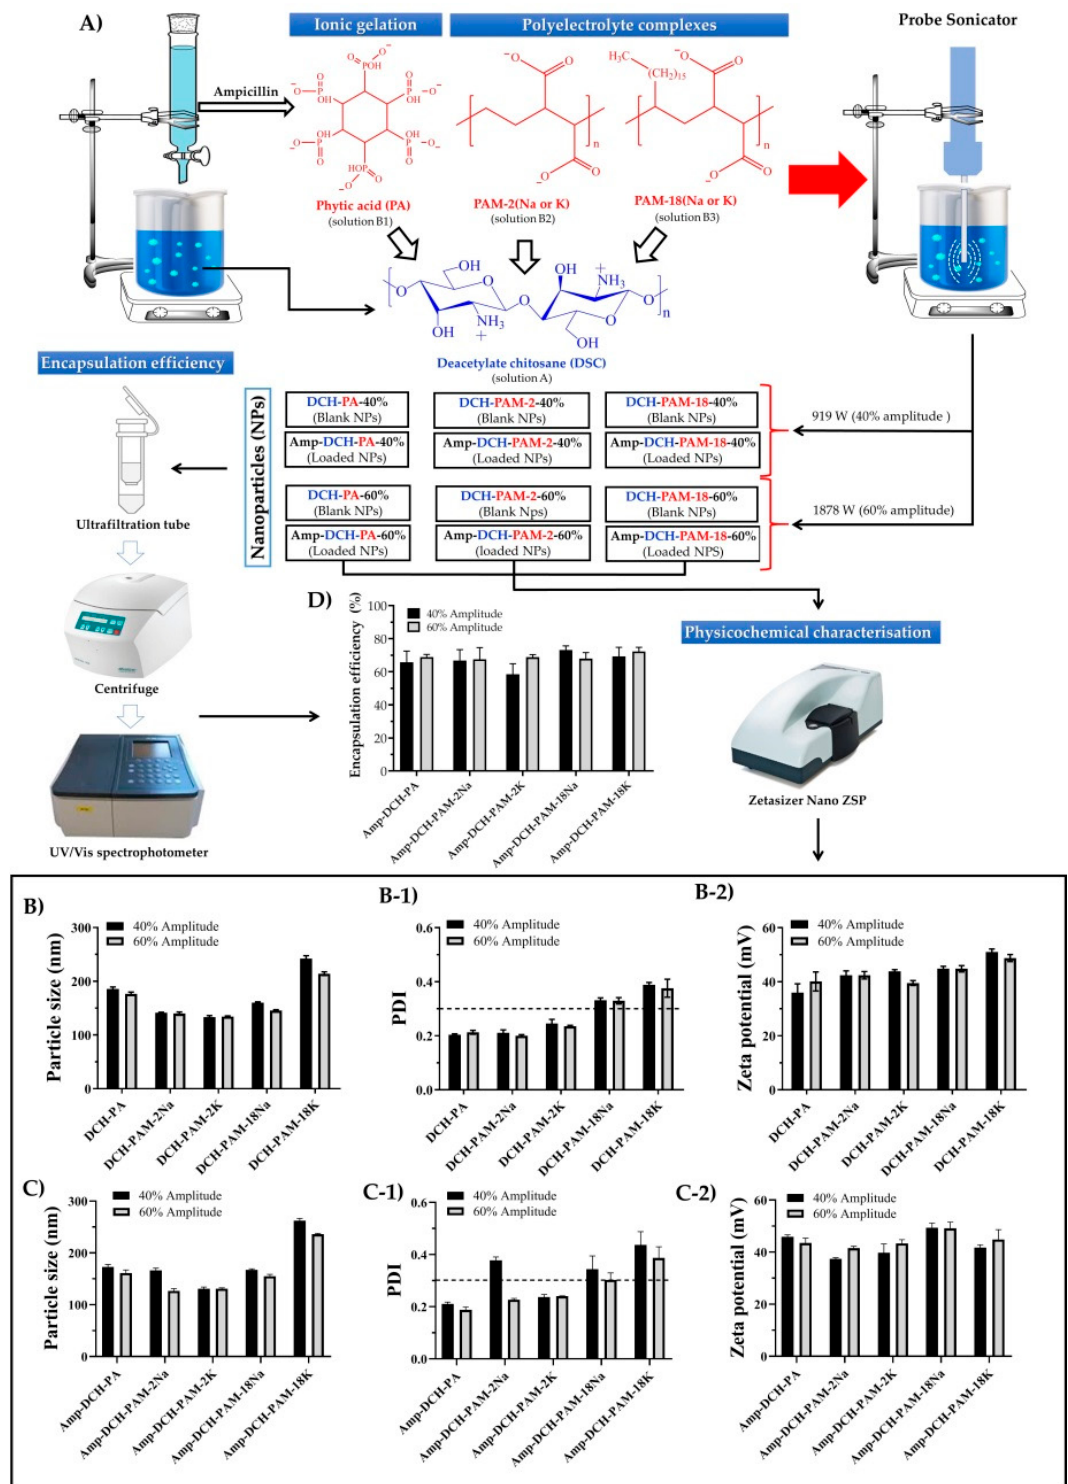
Figure 1. ( A ) Schematic of the formation of chitosan–polyanion nanoparticles unloaded and loaded with ampicillin, using high-intensity ultrasounds. ( B ) Characterisation of particle size, polydispersity index and zeta potential for chitosan–polyanion nanoparticles without ampicillin (blank NPs). ( C ) Characterization of particle size, polydispersity index and zeta potential for chitosan–polyanion nanoparticles loaded with ampicillin. ( D ) Encapsulation efficiency for ampicillin-loaded chitosan–polyanion nanoparticles.